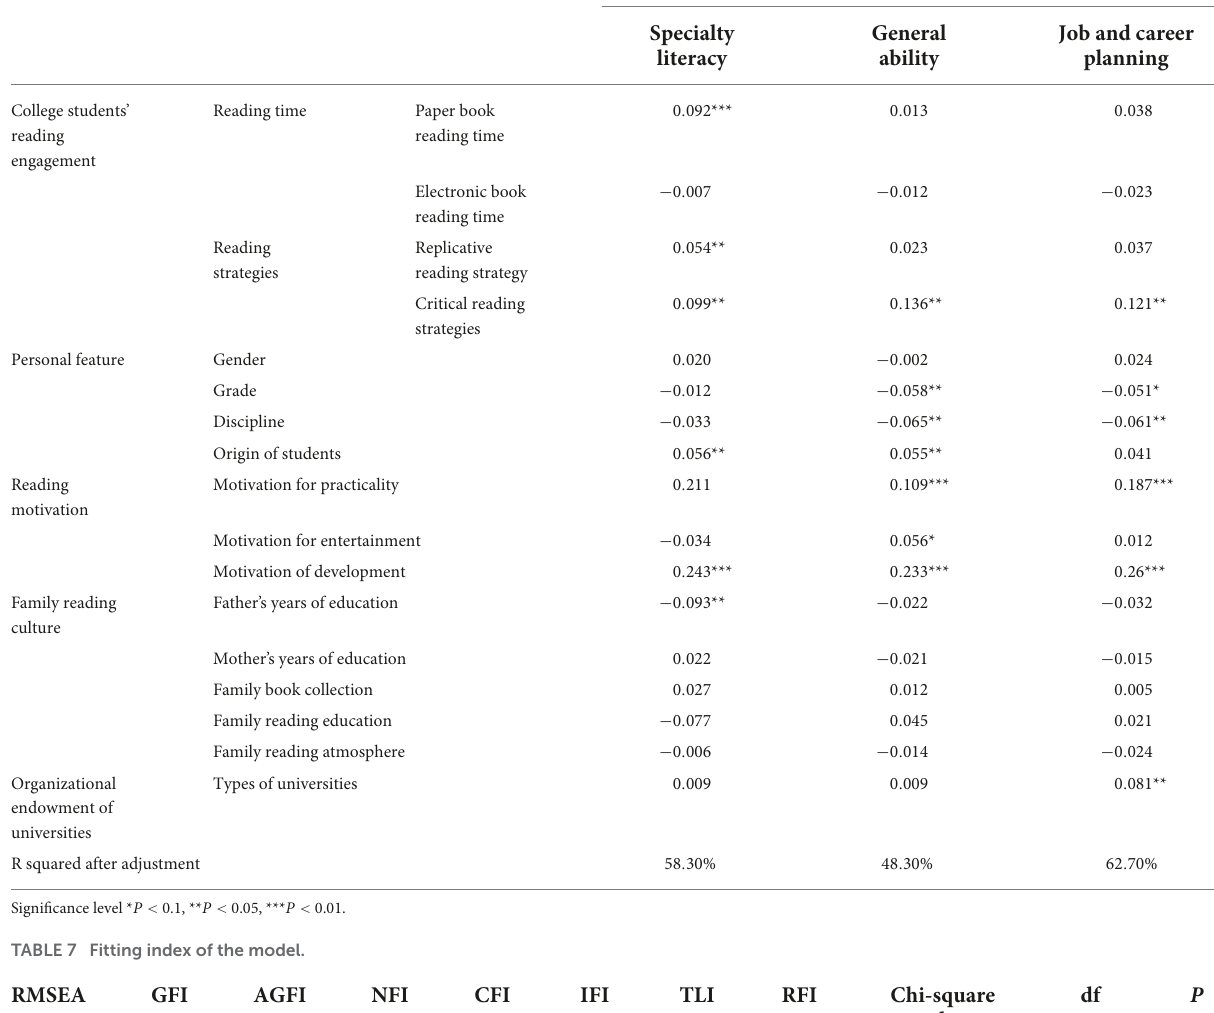
TABLE 6 Results of multiple linear regression of college students’ academic achievement.